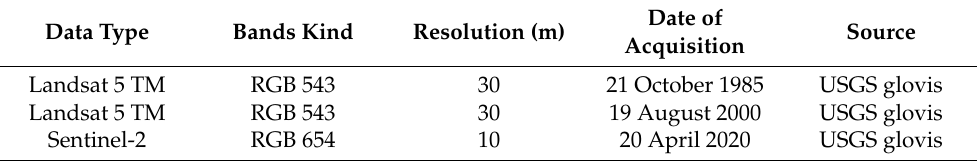
Table 1. Specifications of the Landsat image data used.